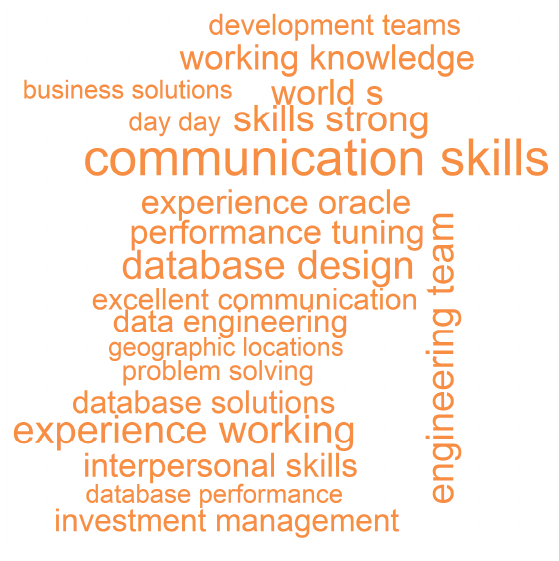
Figure 13. Job Descriptions Visualization—Administrator (unseen data).